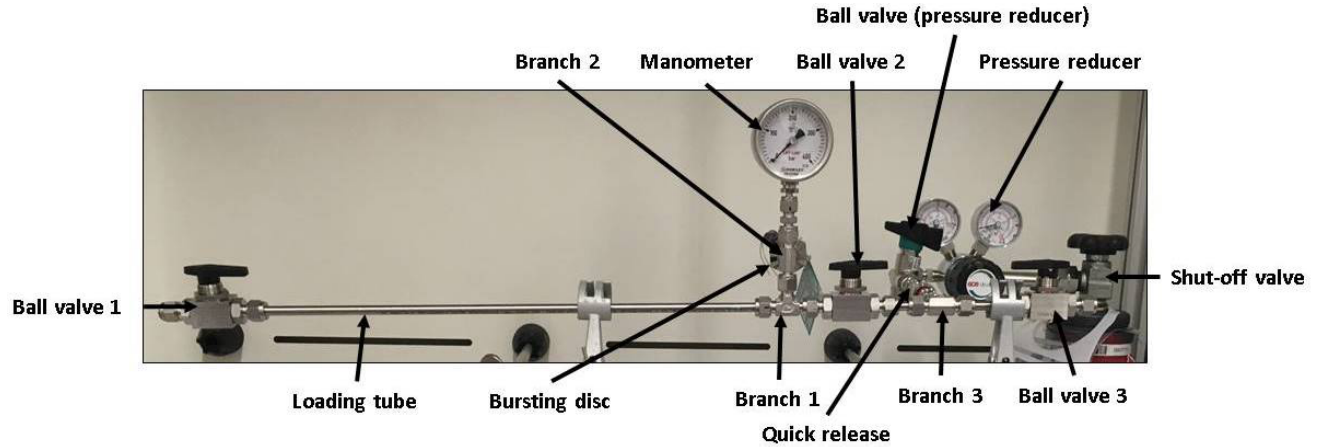
Figure 2. Constructed and used apparatus for the hydrogen charging experiments.